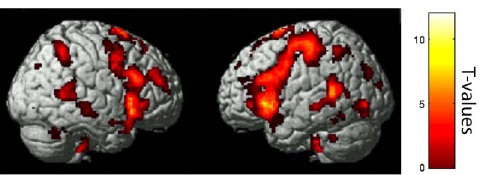
Figure 3. The Dyslexic Group showed reduced activation relative to the Typical Reader Group even when accuracy differences across conditions were equated between the groups. Greater activation for Fast . Slow contrast for Typical Readers versus Medium . Slow contrast for the Dyslexic Group (cluster level FDR corrected results displayed at p , .001). Color bar indicates